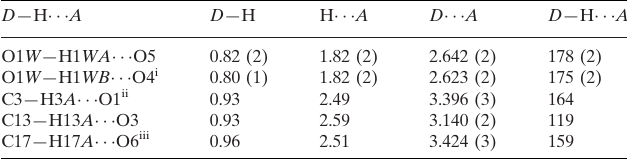
Hydrogen-bond geometry (A˚ , (cid:3)